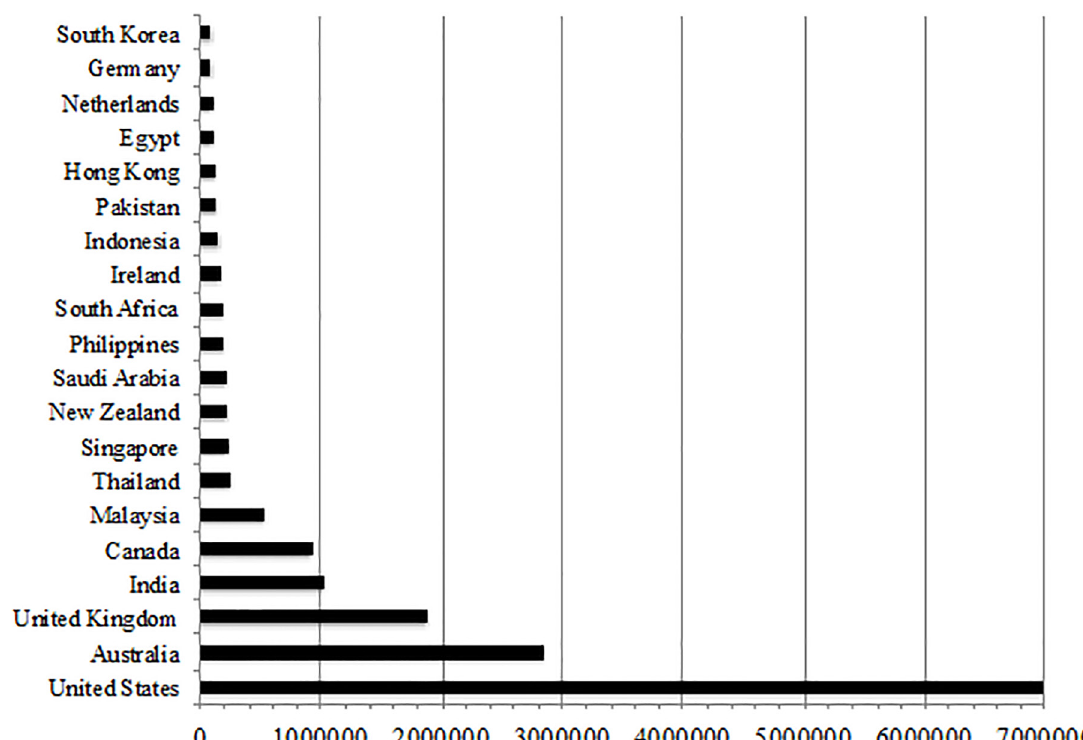
Figure 1. Gross annual sessions from FOAM users in the top 20 countries, 2016. FOAM , Free Open Access Medical